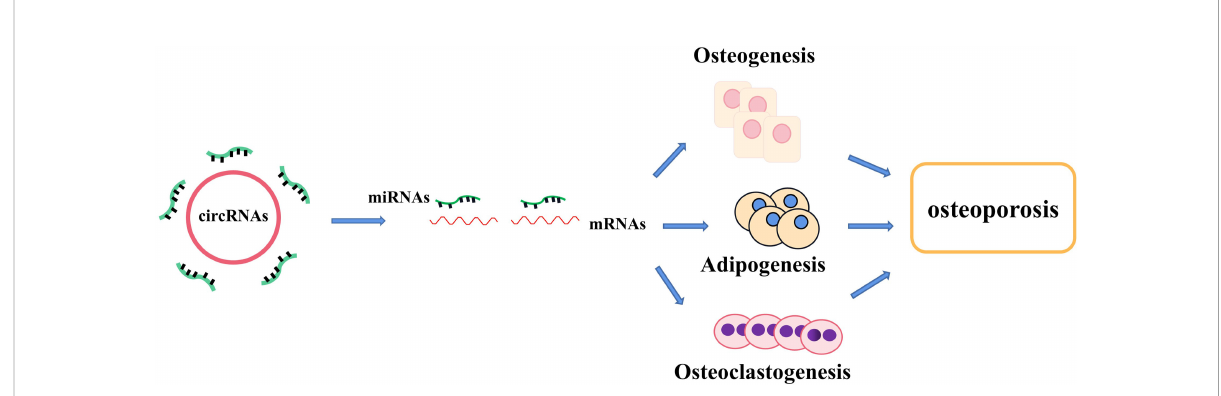
FIGURE 1 The regulatory roles of circRNA – miRNA – mRNA networks in bone development and bone homeostasis. CircRNA – miRNA – mRNA networks regulate the osteogenesis, adipogenesis, and osteoclastogenesis in several types of cells and provide a therapeutical approach to treating abnormal bone metabolism including